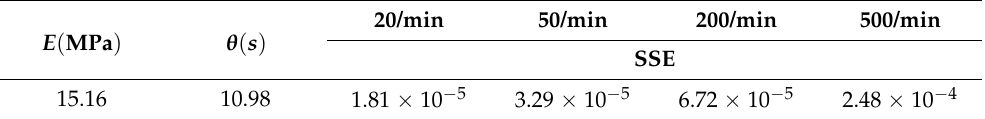
Table 1. Derived material parameters and error values of four uniaxial tests for nitrile rubber. Figure 1. Comparison of the experimental data and prediction results obtained from the proposed model at different stretch rates, ( a ) 20/min, ( b ) 50/min, ( c ) 200/min, ( d ) 500/min.